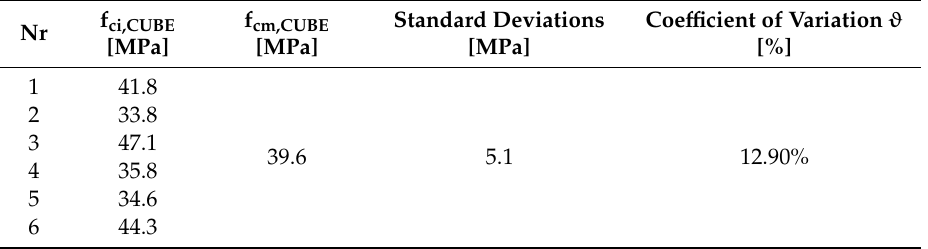
Table 1. Concrete compressive strengths determined from sclerometric tests.